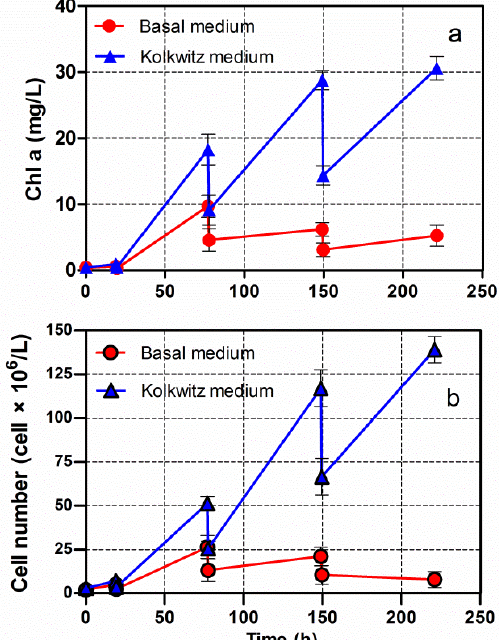
Figure 2. ( a ) Changes in Chl-a and ( b ) cell numbers versus time in Chlorella vulgaris CCALA 896 grown under repetitive batch ( i.e. , semi-continuous) regimen